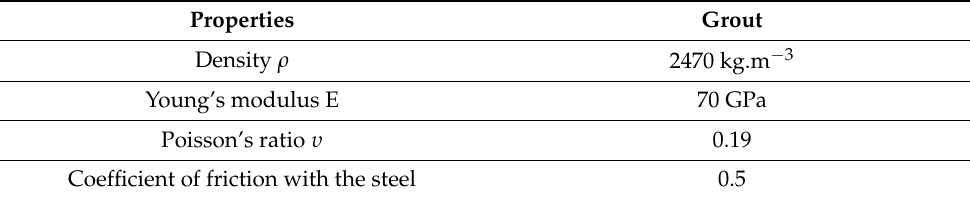
Table 6. Mechanical properties of Ducorit